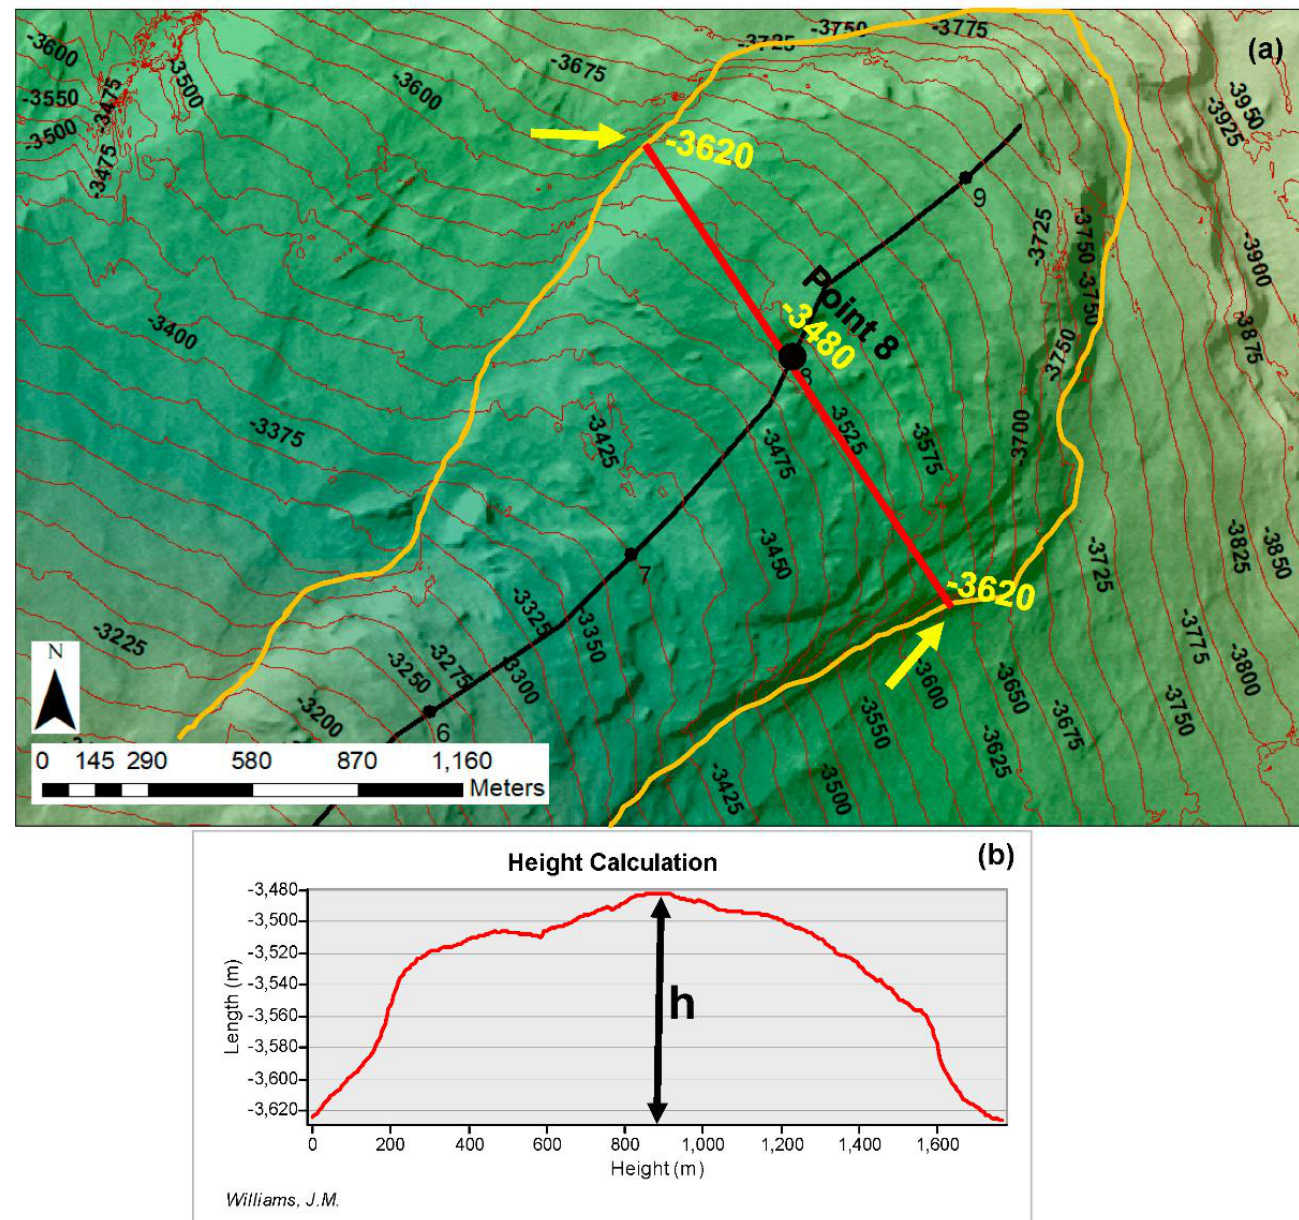
Figure 7. ( a ) Ground estimation method using bounding elevations of a perpendicular drawn line to a lobate feature boundary (orange line) and from the centerline transect point. In this example, the Point 1 elevation is − 3000 m and basal elevation is − 3100, giving a height of 100 m. ( b ) Basal elevation range below the cross-sectional profile and the underlying ground elevation with no basal scouring. The maximum thickness h corresponds to the center of the transect line.